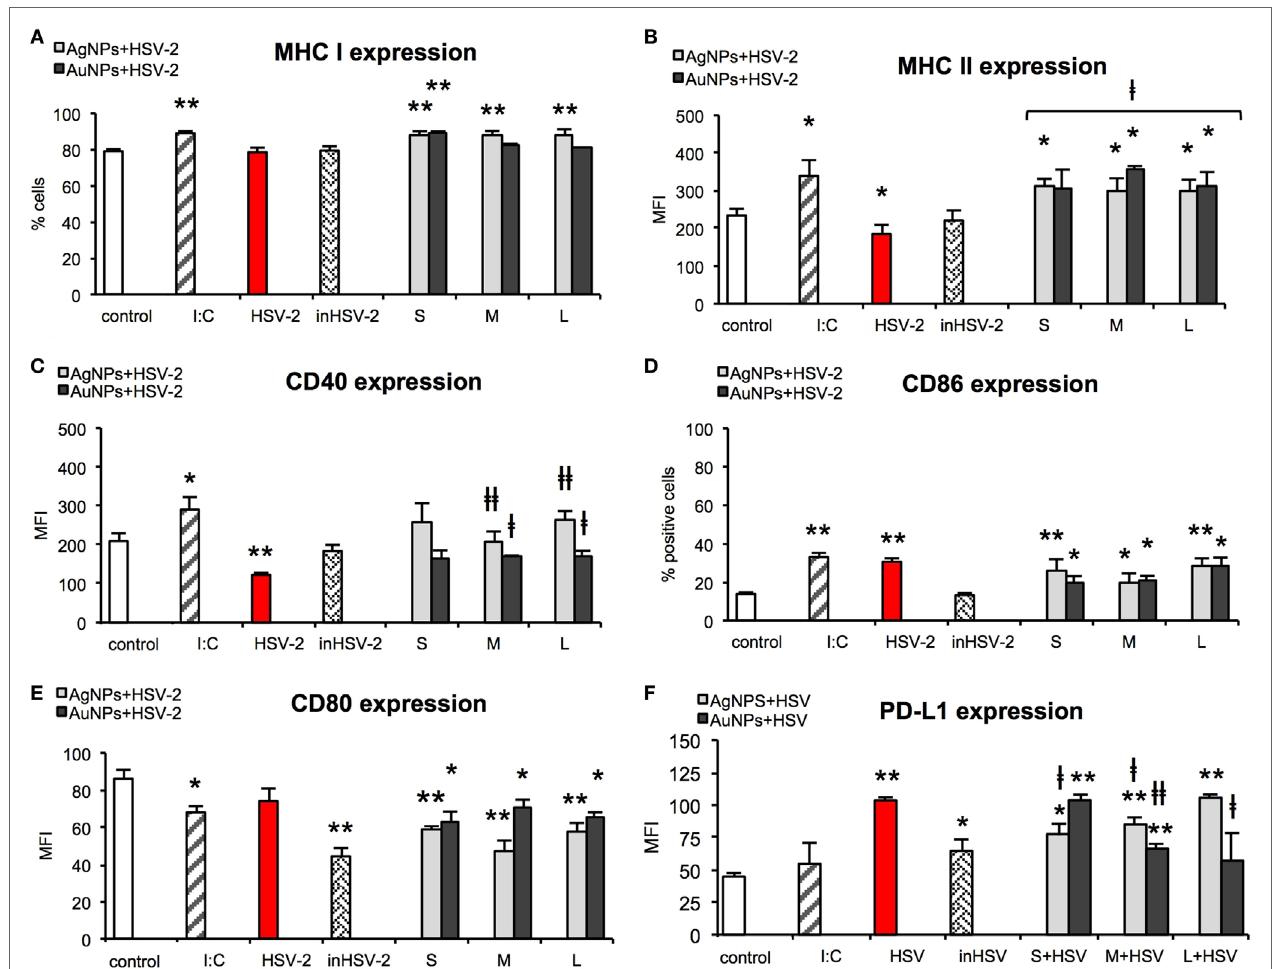
FigUre 9 | Nanoparticles (NPs)-treated HSV-2 stimulate maturation of dendritic cells (DCs). MHC class I (a) , MHC class II (b) , CD40 (c) , CD86 (D) , CD80 (e) , and PD-L1 (F) expression on the JAWS II cells after 24 h exposure to HSV-2 treated with 2.5 µg/ml of 10 nm (S), 37 nm (M), 59 nm (L) TA-AgNPs and 10 nm (S), 34 nm (M), 62 nm (L) TA-AuNPs. Each bar represents the mean from 5 experiments ( N = 5) ± S.E.M. *Significant differences with p ≤ 0.05, ** p ≤ 0.01 in relation to untreated control, ǂ p ≤ 0.05, and ǂǂ p ≤ 0.01 calculated in relation to the HSV-2 infected